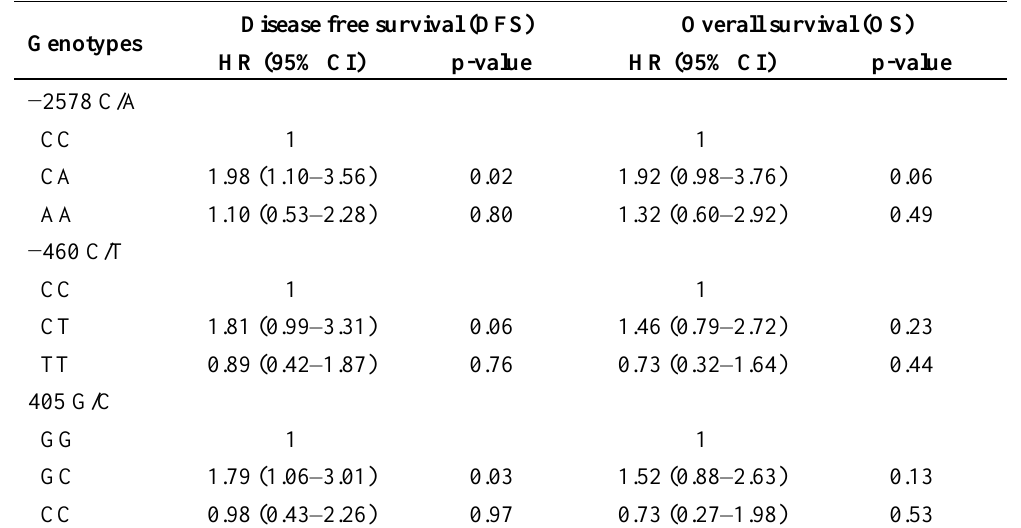
Table 3. Multivariate survival analysis according to the VEGF-A SNPs. Validation cohort, n = 295. Disease free survival Genotypes